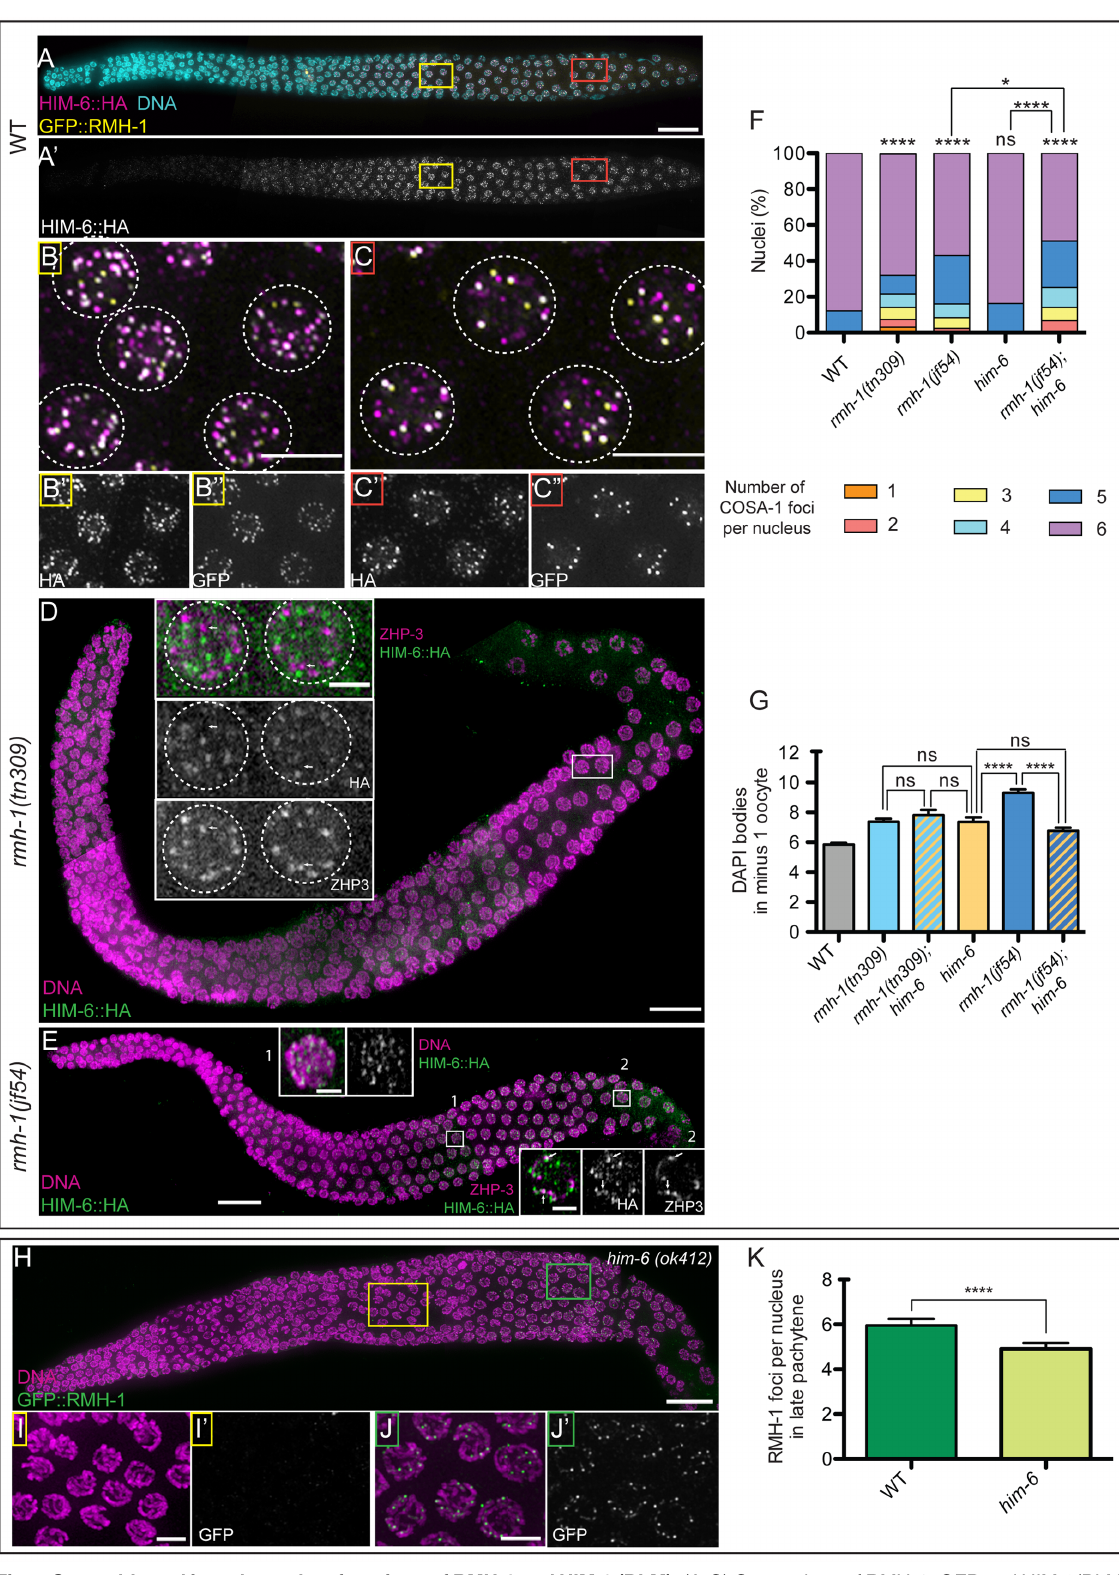
Fig 5. Separable and interdependent functions of RMH-1 and HIM-6 (BLM). (A-C) Comparison of RMH-1::GFP and HIM-6(BLM)::HA localization in wild- type germ cells. (B – B 00 ) In mid pachytene (MP) nuclei, a high number of GFP::RMH-1 and HIM-6::HA foci are present, and most colocalize. (C – C 00 ) In late pachytene (LP), HIM-6 and RMH-1 colocalize in bright foci, but additional HIM-6 signals are present at other sites. (D) In rmh-1(tn309) , HIM-6 foci are